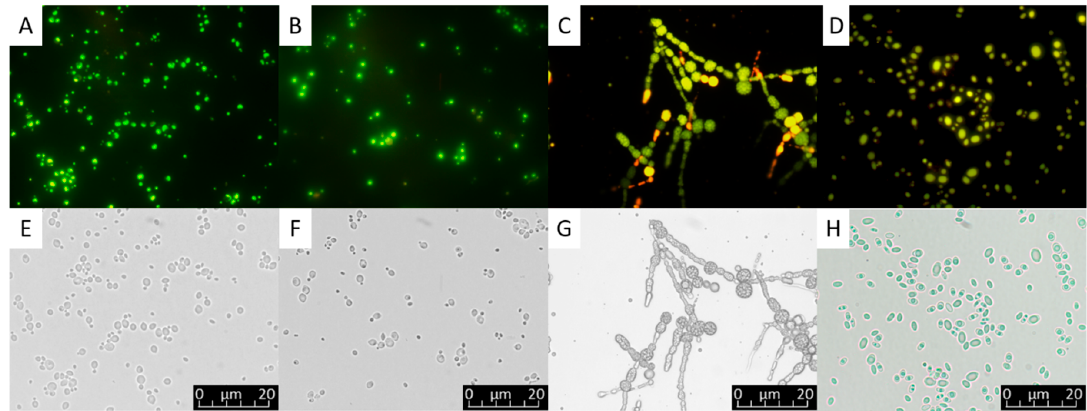
Figure 1. Lipid droplets visualized under light microscope (400×) within yeast cells and the mycelium of a filamentous fungus as shown through fluorescent filter after Nile red staining ( A – D ) and without fluorescence filter ( E – H ). ( A , E ) Meyerozyma guilliermondii , ( B , F ) Scheffersomyces coipomensis, ( C , G )